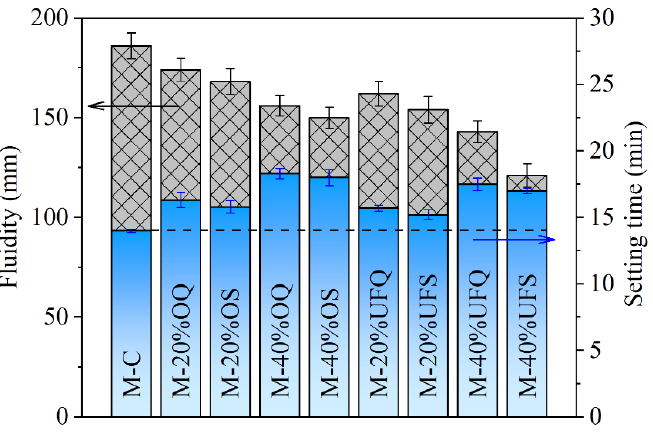
Figure 2. Fluidity and setting time of the fresh MKPC mortar.